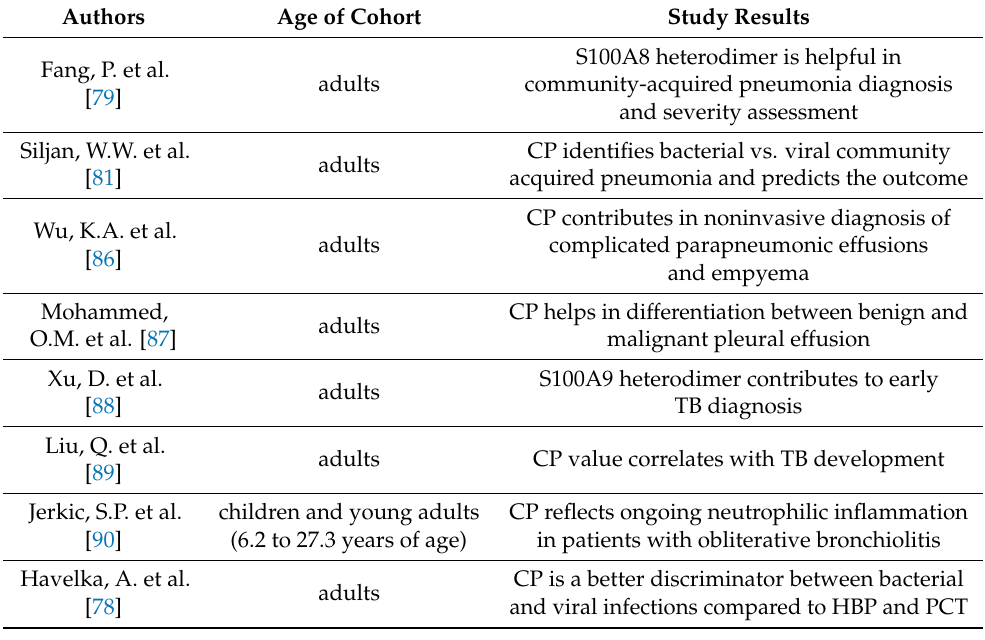
Table 2. CP in infectious diseases, human studies.